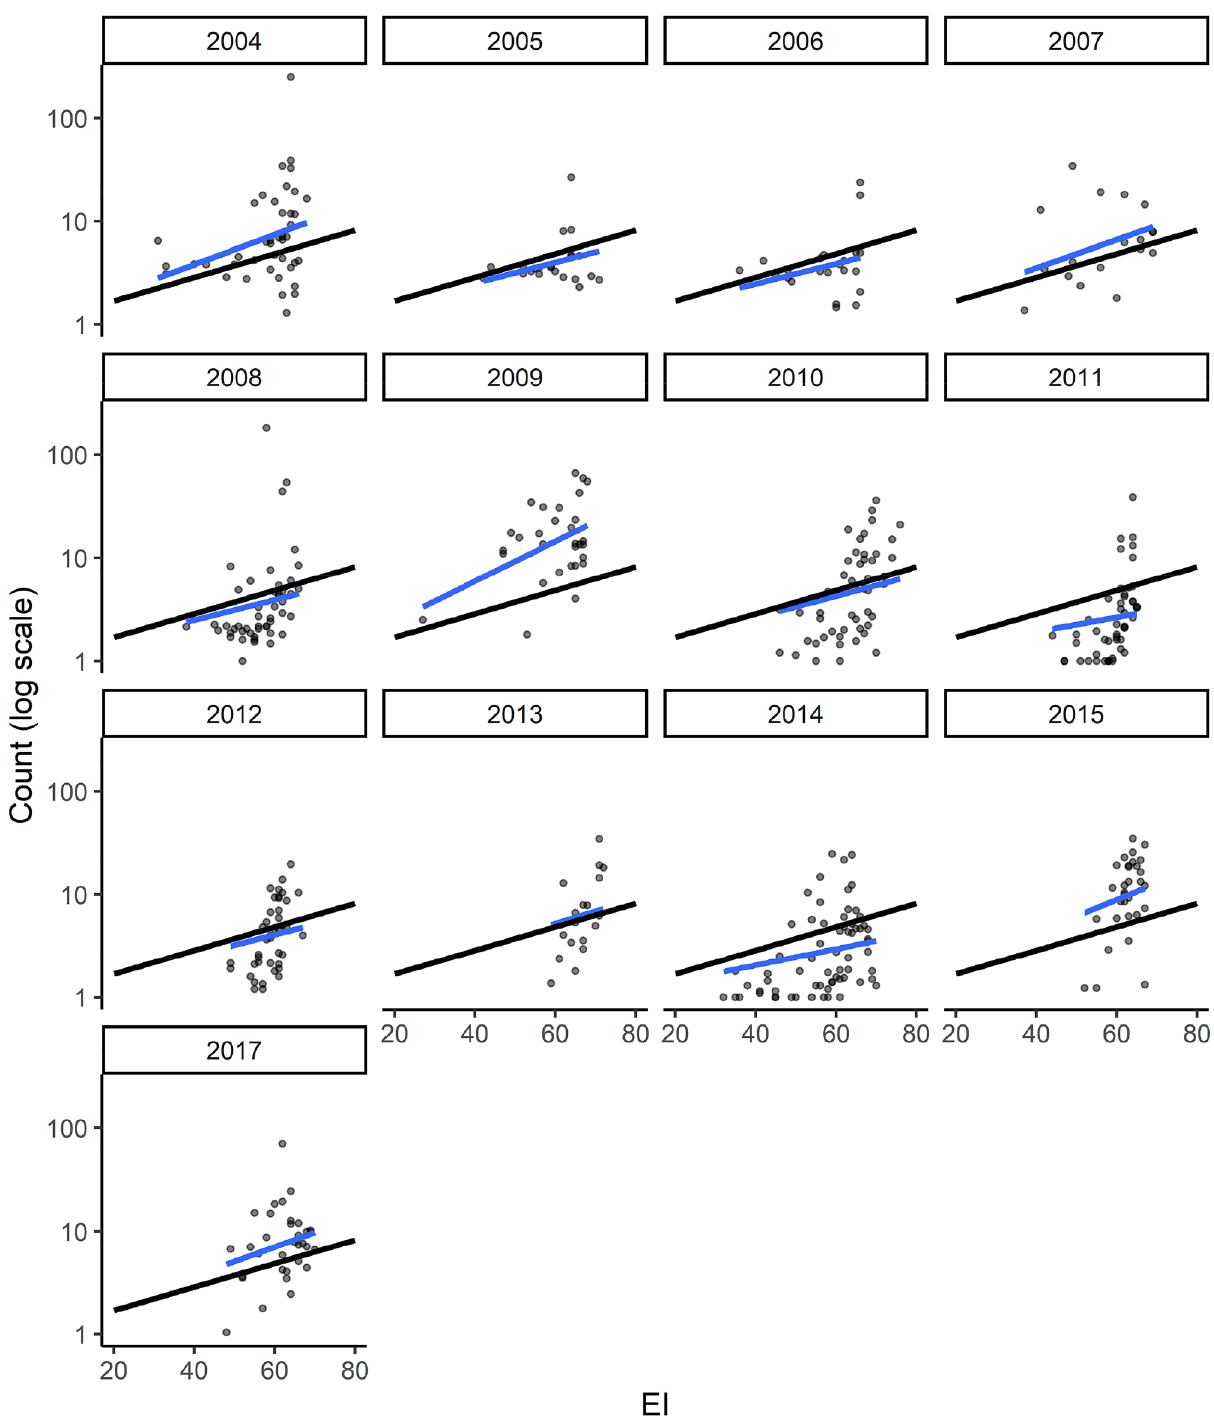
line represents slope fitted across all years and blue line represents slope fitted to individual years’